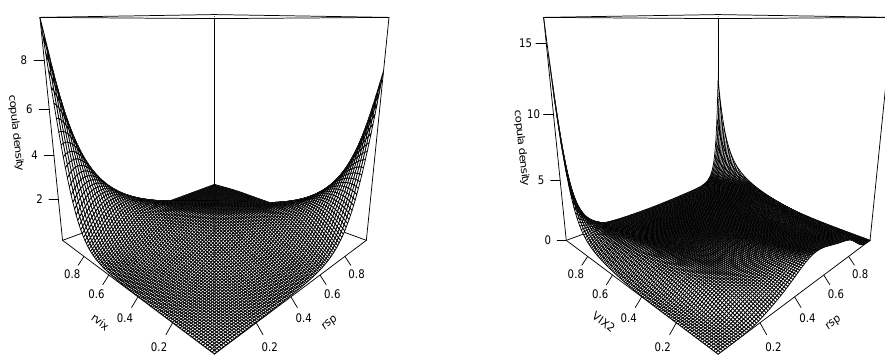
Figure 2. Joint Copula Density Functions Estimated by Nonparametric Copula Method ( Left : rvix t and rsp t ; Right : VIX 2 and rsp t t